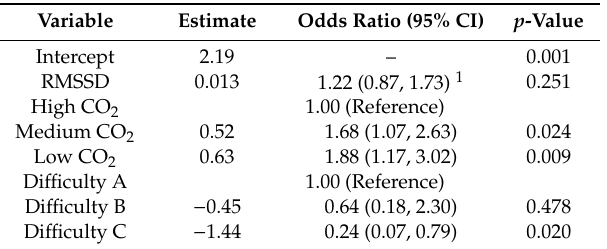
Table 5. GAMM results of RMSSD, CO 2 condition and maneuver di ffi culty on passing a maneuver, controlling for examiner and flight profile number and treating pilot ID as a random e ff ect.